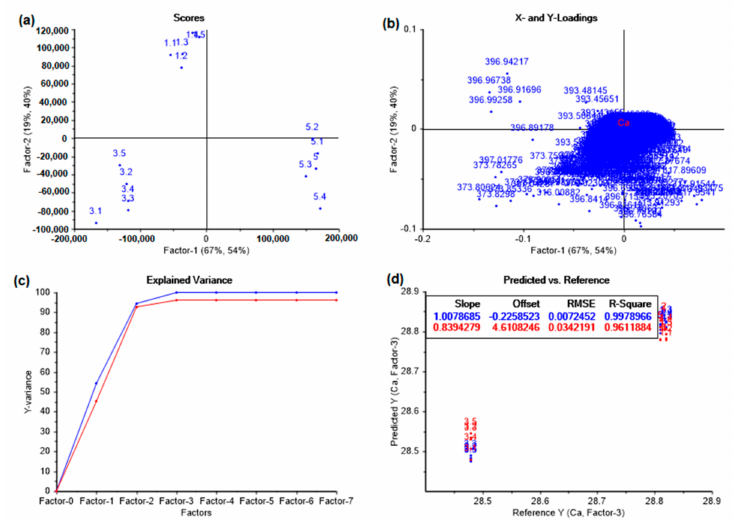
Figure 11. ( a ) Score plot of Partial Least-Square Regression (PLSR) model, ( b ) Loading plot of PLSR model, ( c ) Explained variance plot in PLSR model, and ( d ) Predicted vs.